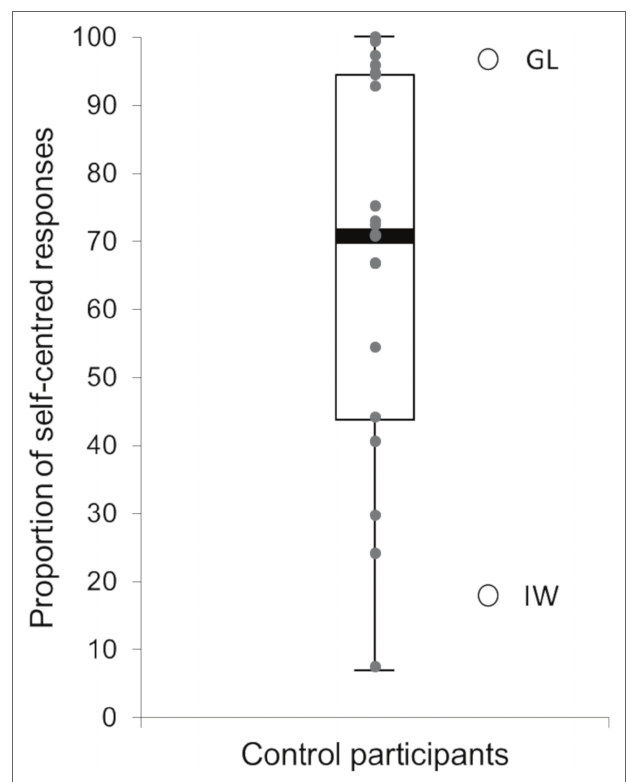
FIGURE 3 | Participants’ global proportion of self-centered responses. The box-and-whisker plot represents control participants’ data. The gray circles represent controls’ individual data. The two white circles represent the two deafferented patients’